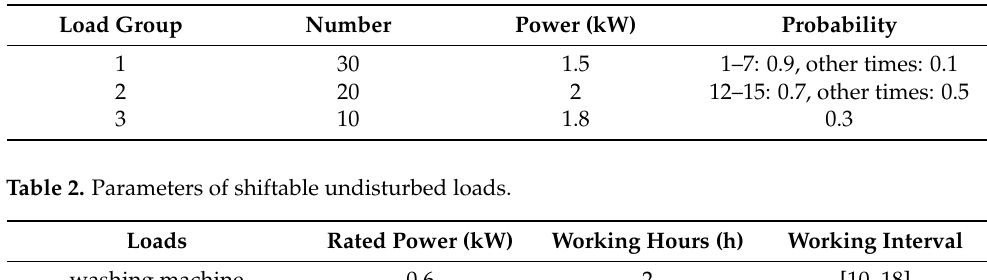
Figure 8. Loads, output powers of PV and WT.